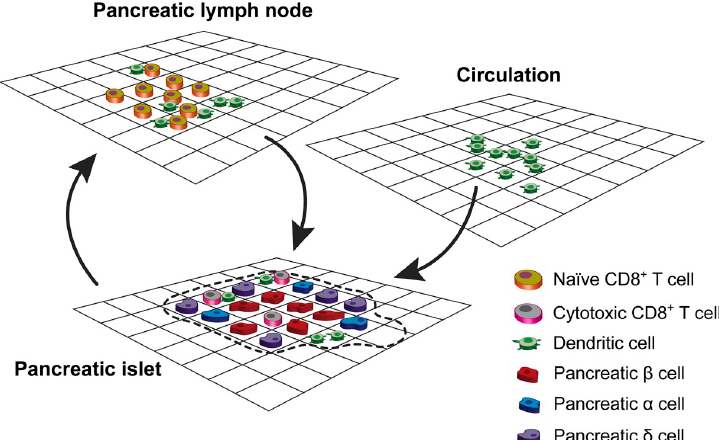
Fig 1. Schematic illustrating pancreatic islets, circulation, and PLNs in the NOD mouse model. Patches are shown by the background grids in NetLogo, turtles are mobile agents moving over the background grids (e.g. Na ï ve CD8 + T cell). DCs and CD8 + T cells migrate from circulation and/or PLNs to pancreatic islets, which contribute to T1D progression. One pancreatic islet is shown (the area restricted by the dashed curve in the pancreas). Pancreatic islets may overlap and form clusters of islets in the